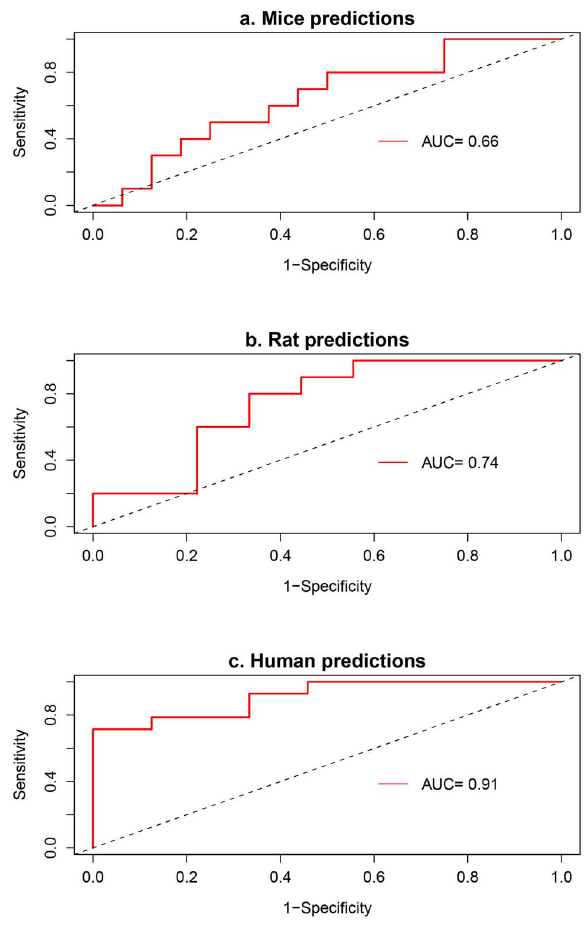
Figure 1. Receiver-operator characteristics (ROC) curves of carcinogenicity predictions using the pathway-based predic- tion models across three species. (a. Mice, b. Rats and c. Humans) The legend in the sub-plots provides the area-under-the- curve (AUC) for the corresponding ROC curve. The curves for mice, rats and humans are based on datasets corresponding to those in Tables 1, Table S1 and Table 3 respectively.